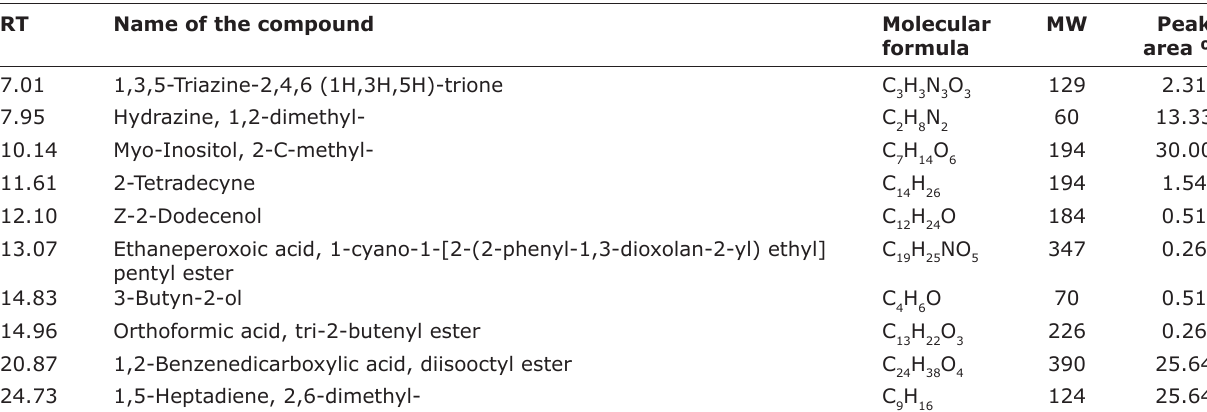
Table-5: Phytocomponents identified in the ethanolic extract of I. tinctoira . RT Name of the compound Molecular